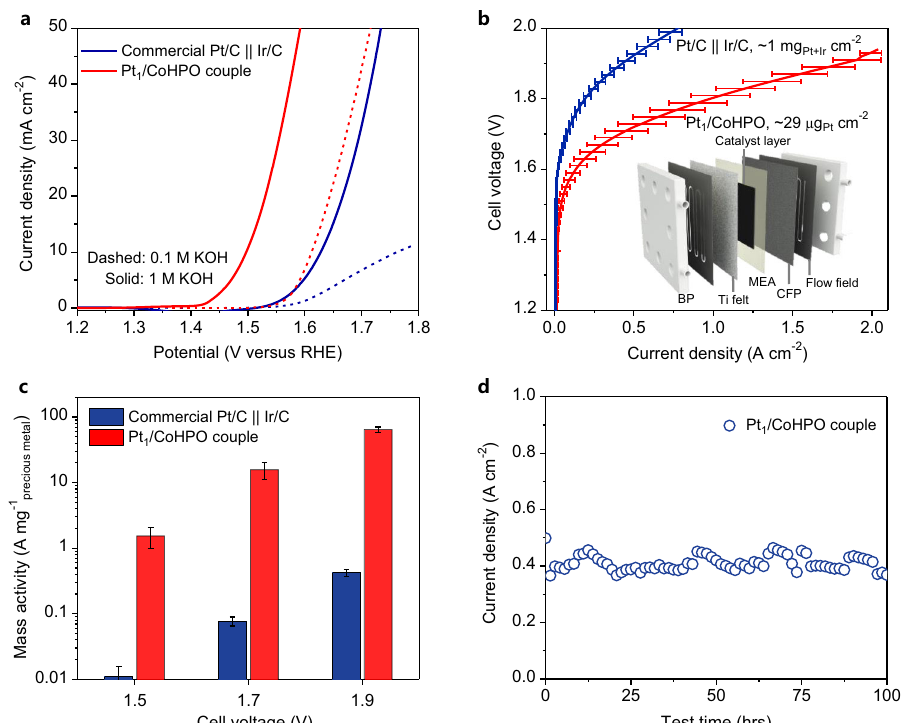
Fig. 5 AEMWE performance. a Electrocatalytic overall water-splitting properties in a H-type cell of the Pt 1 /CoHPO as both anodic and cathodic catalysts. The benchmark Pt/C + Ir/C as a catalyst is also included for comparison. b Electrocatalytic water-splitting properties of the Pt 1 /CoHPO and the benchmark Pt/C + Ir/C measured in an alkaline AEMWE setup operating at 80 °C. Inset , a typical single AEMWE setup comprising a membrane electrode assembly (MEA) and bipolar plates (BP) with a fl ow fi eld are presented, wherein the MEA comprises a gas diffusion layers with a Ti felt and a carbon fi ber paper (CFP) at the anodic and cathodic sides, respectively, anodic and cathodic catalyst layers and an anion exchange membrane (AEM). c Mass activities comparisons of the Pt 1 /CoHPO and the commercial Pt/C + Ir/C at various cell voltages, showing over two orders of magnitude higher of mass activity for the Pt 1 /CoHPO compared with that of commercial Pt/C + Ir/C. d Stability tests of the Pt 1 /CoHPO-based MEA. Error bars in b , c represent the average values (mean ± s.d., n =